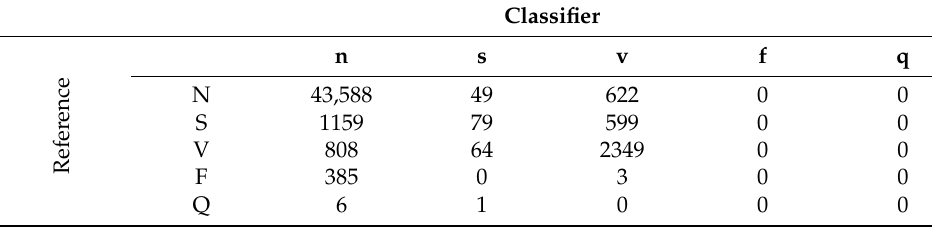
Table 8. Confusion matrix SVM.